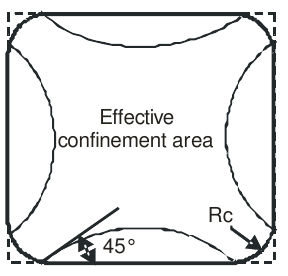
Fig. 2. Effectively confined concrete in a square